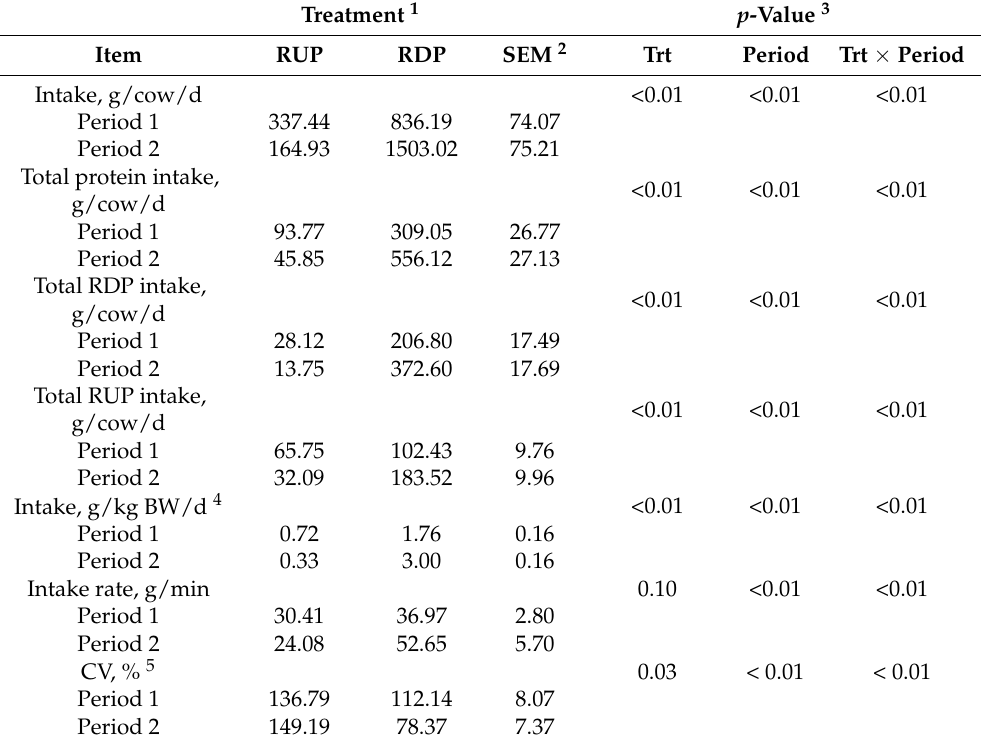
Table 6. Intake, intake rate, and % coefficient of variation (% CV) data of cows supplemented with rumen undegradable or degradable protein while grazing improved dryland